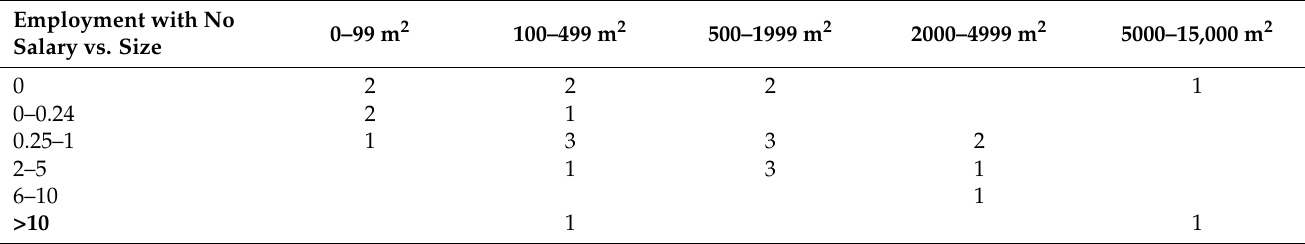
Table 4. Number of non-salaried jobs according to the size range of the aquaponic